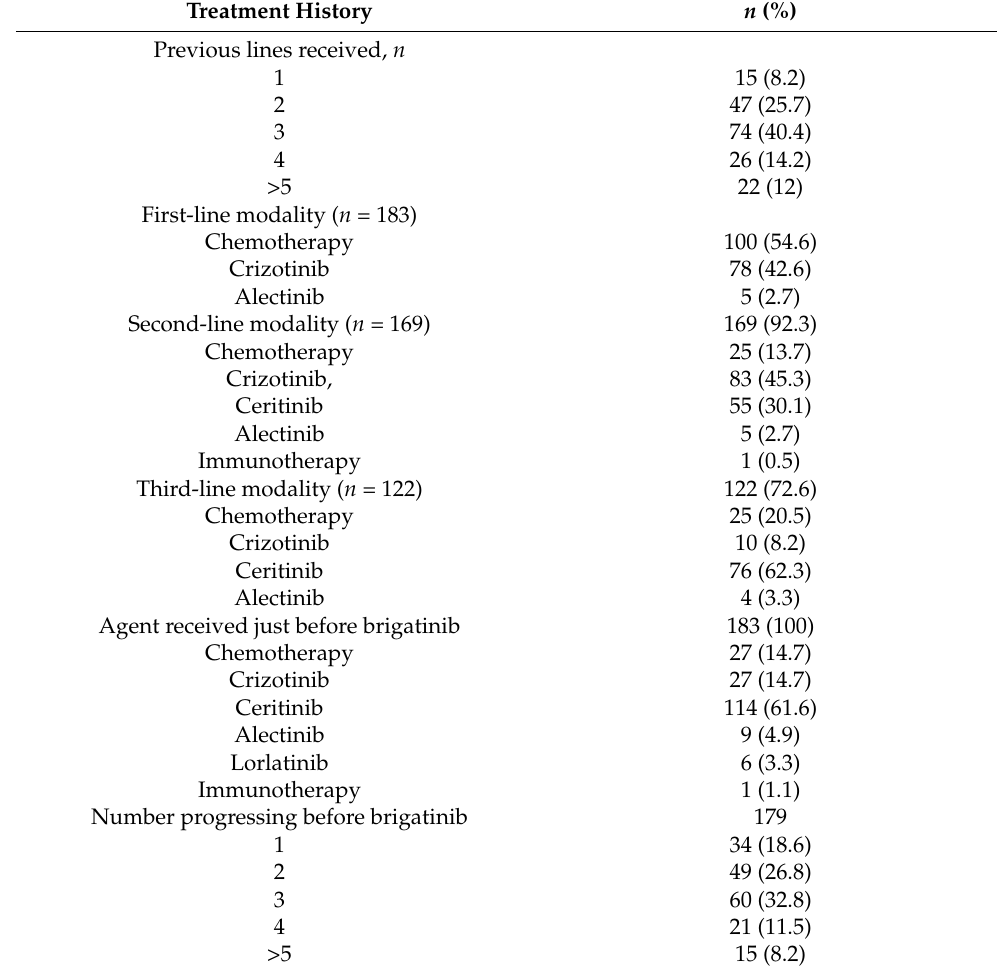
Table 2. Systemic treatment modalities given to the 183 patients with ALK+ advanced NSCLCs before brigatinib.